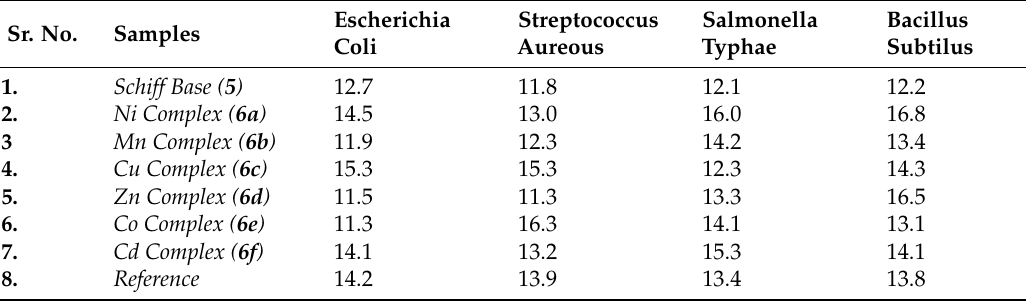
Table 2. The results of anti-bacterial activity of naproxen derivatives 6a – f . Sr.